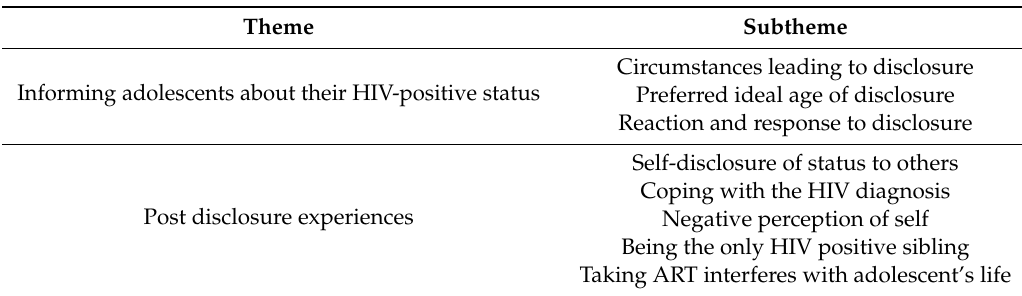
Table 3. Summary of themes and